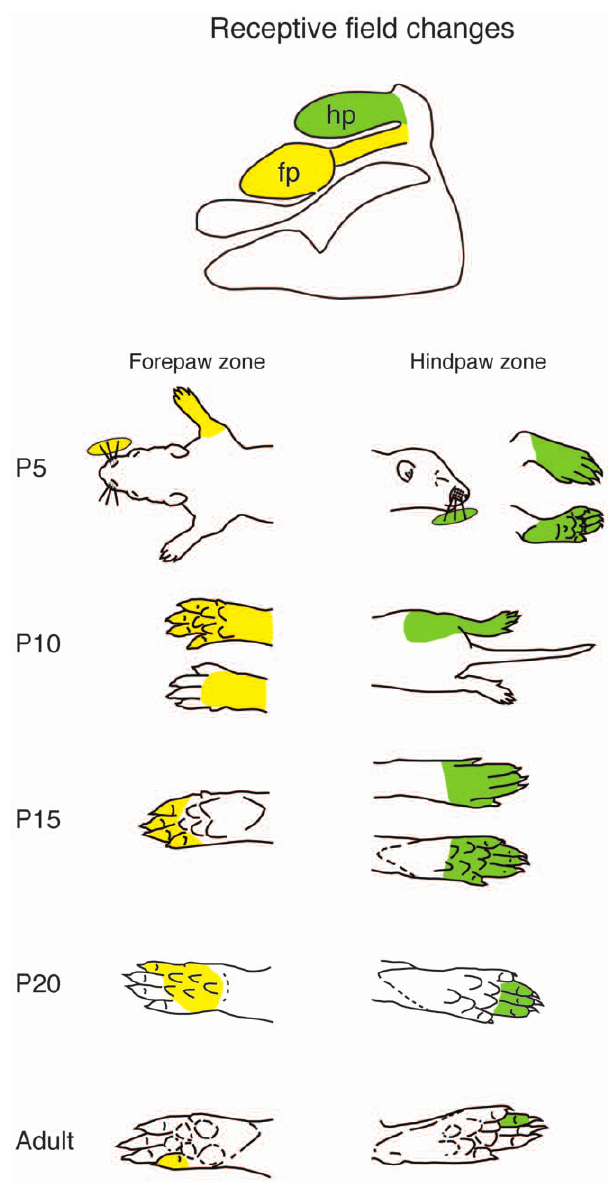
Figure 14. Changes in receptive field size and configuration at different developmental ages. The top illustration is a schematic of the body map in adults with the hindpaw zone marked in green and the forepaw zone marked in yellow. The receptive fields below for the different postnatal ages are for neurons in recording sites in each of these zones. At P5 there were very few recording sites with neurons that had receptive fields on either the forelimb or hindlimb. For those that did, receptive fields were large, and encompassed the vibrissae as well. With progressively older postnatal ages, the size of receptive fields for neurons in these zones decreased, and in adults, were small and often encompassed only a single digit or toe. Conventions as in previous